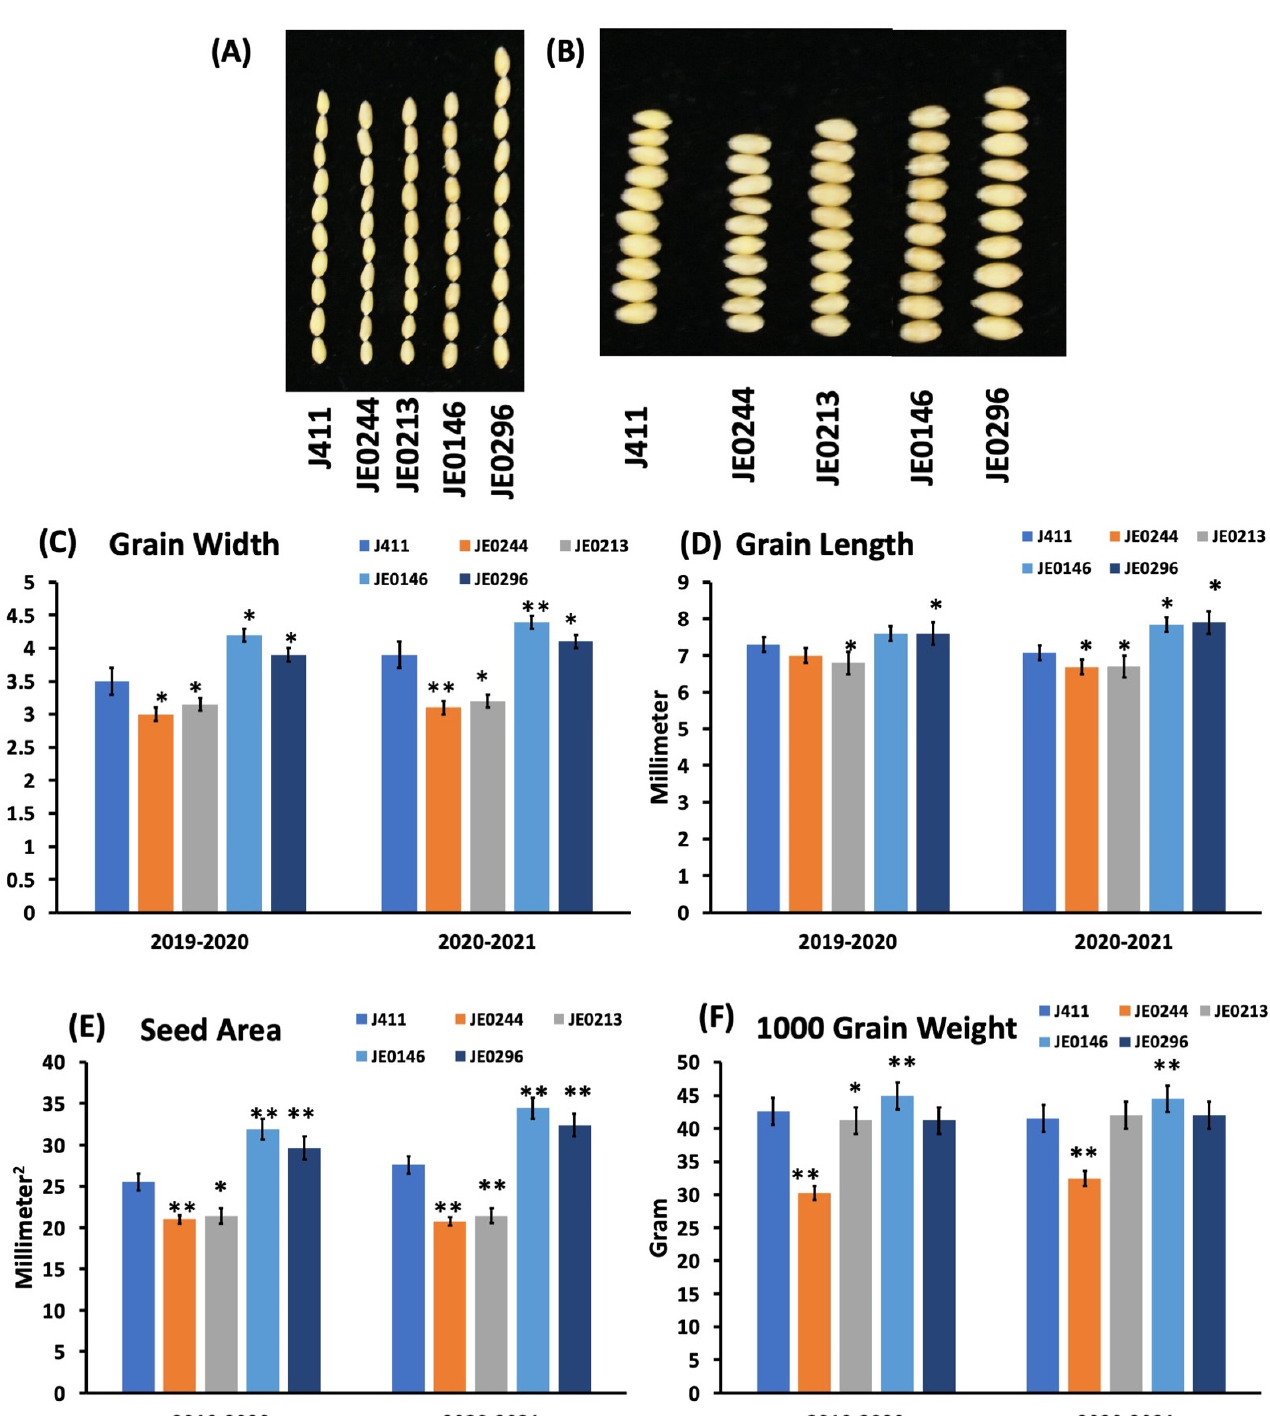
Figure 3. Study of morphological traits in the mutant lines. The graphs show the distribution of morphological traits for the wild-type and resistant starch mutant wheat lines: ( A ) image of the mutant lines and WT for grain length; ( B ) image of the mutant lines and WT for grain width; ( C ) grain width; ( D ) grain length; ( E ) seed area; and ( F ) 1000-grain weight. Asterisks (*, **) indicate that the trait mean was significantly different ( p -value < 0.01) between the WT and mutant lines.